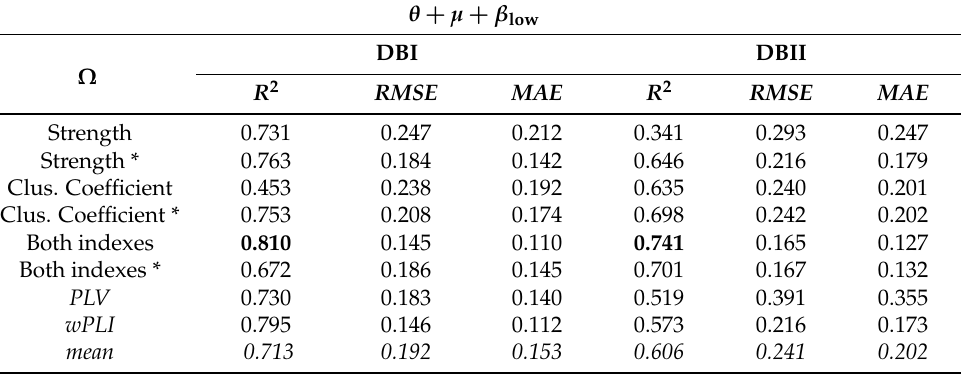
Table 4. Prediction performance of the Wide&Deep neural network regression fed by the tested functional connectivity indicators extracted from the resting-state data, employing the validation procedure that includes the Monte Carlo dropout layers combined with the threshold procedure. The input predictor sets denoted with * are thresholded. Bold numbers show the best result of each